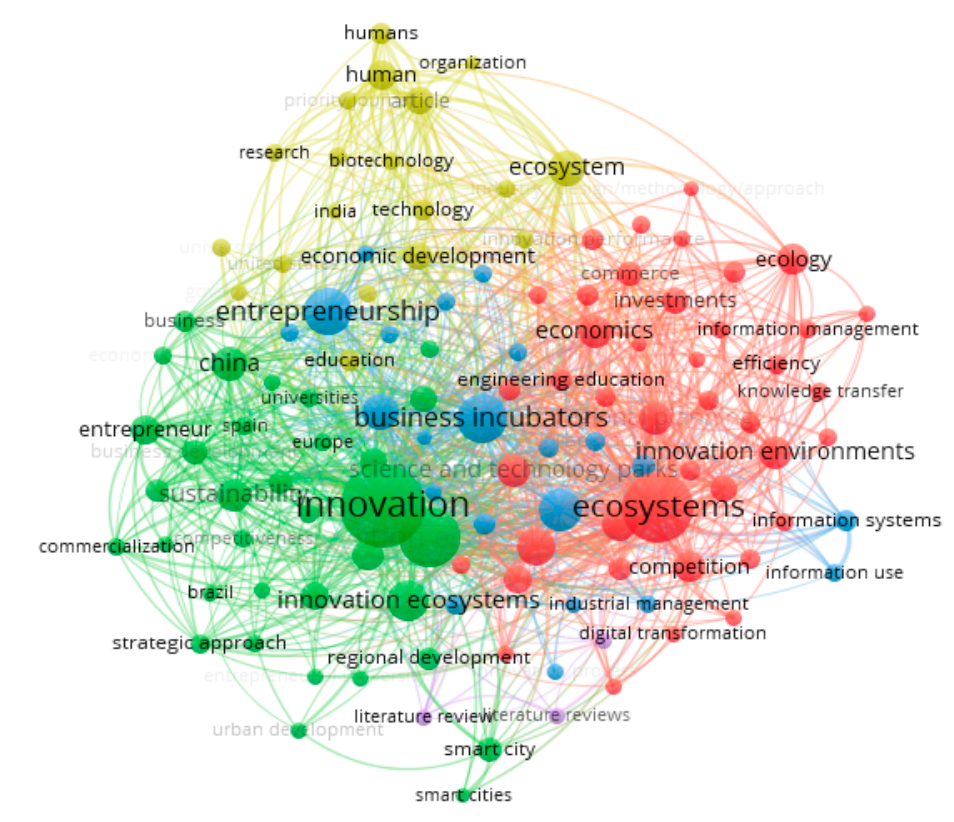
Figure 6. Cluster map 2016 to